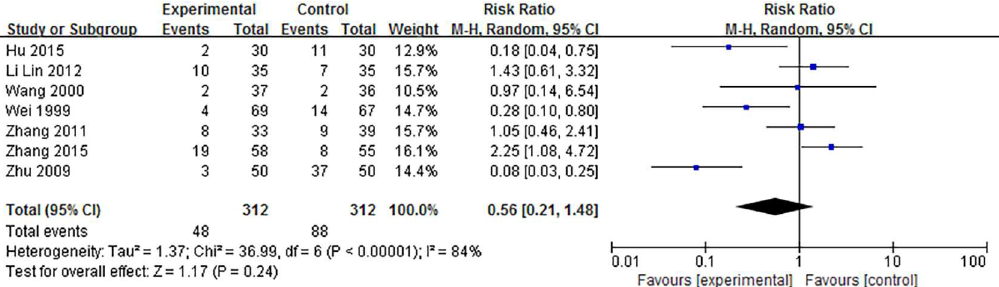
Fig 7. Forest plot of safety profile and adverseevents of SMT-treated FD. SMT = Si-Mo-Tang oral liquid, FD =